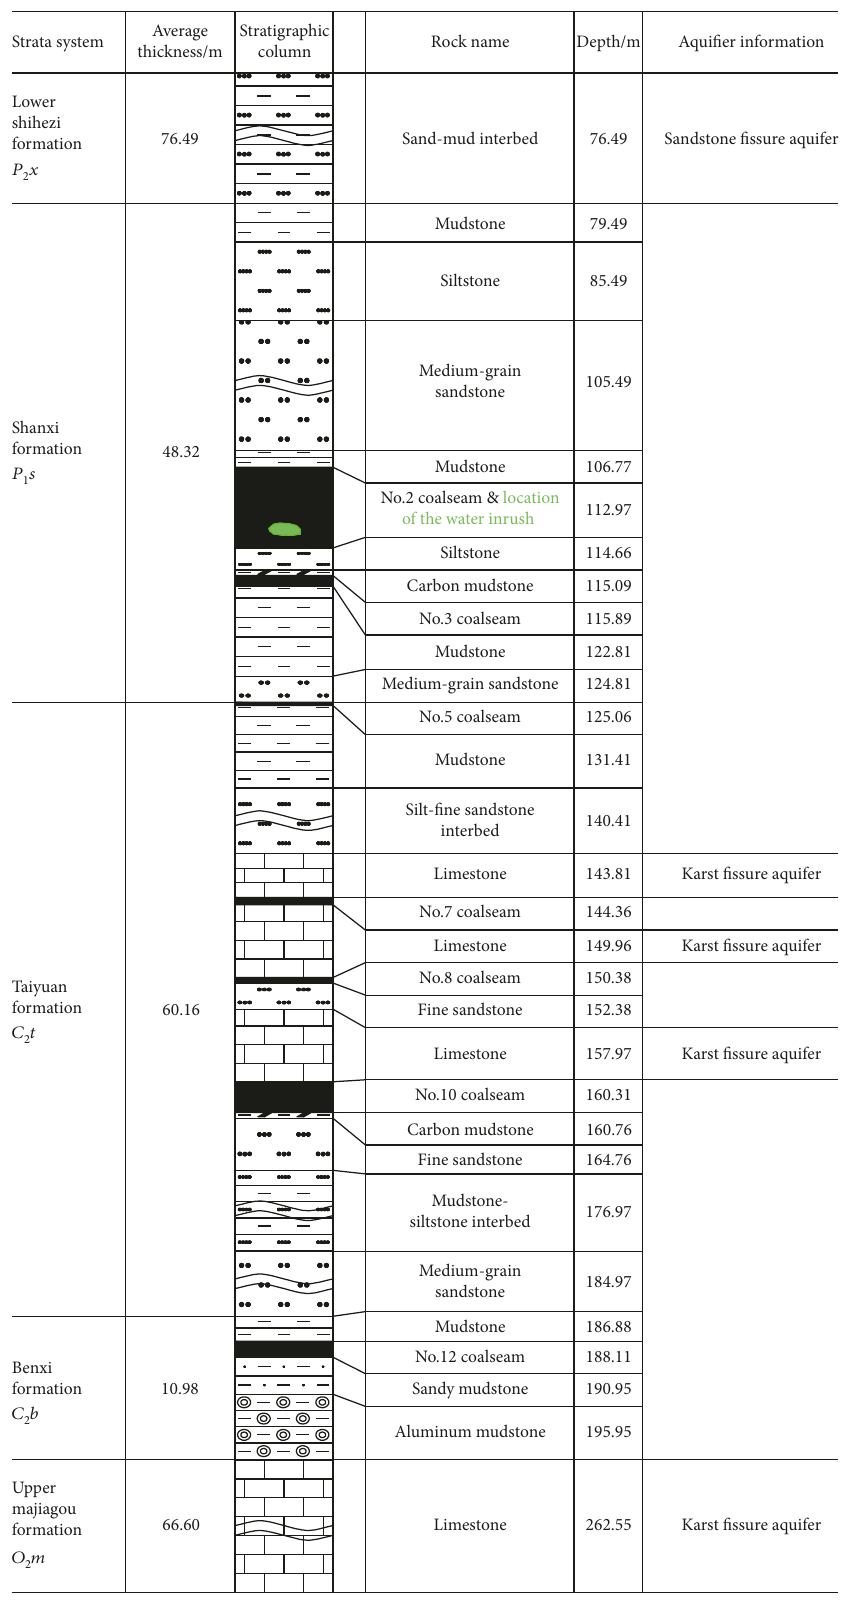
Figure 2: The strata and aquifer distribution at the Wangjialing coal fi